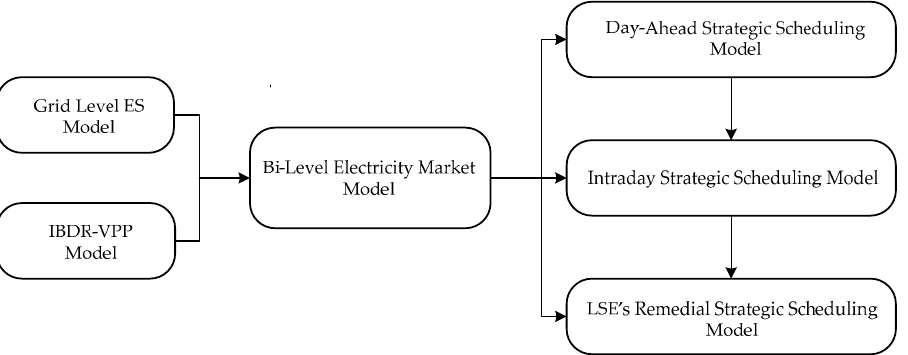
Figure 1. Overview of the remedial strategic scheduling model. ES, energy storage; IBDR-VPP, interruptible load-based demand response virtual power plant; LSE, load serving entity.